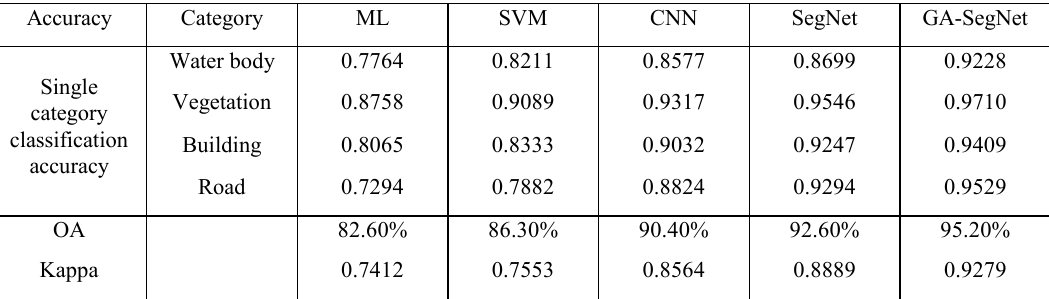
Using ML, SVM, CNN, SegNet semantic model and